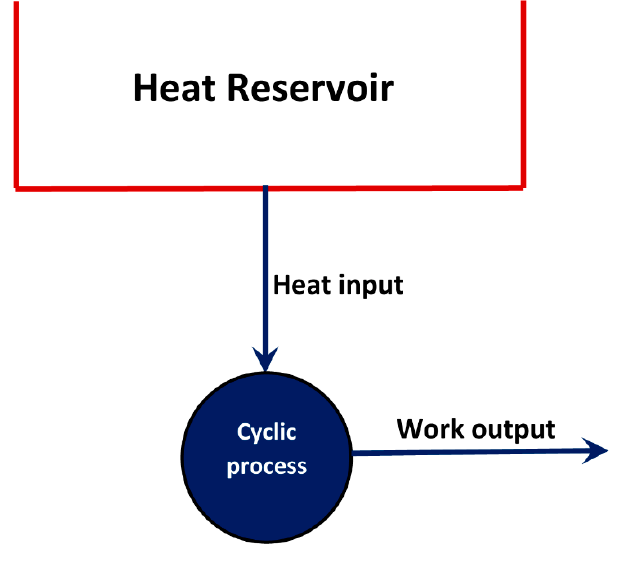
Figure 1. Impossible heat engine.